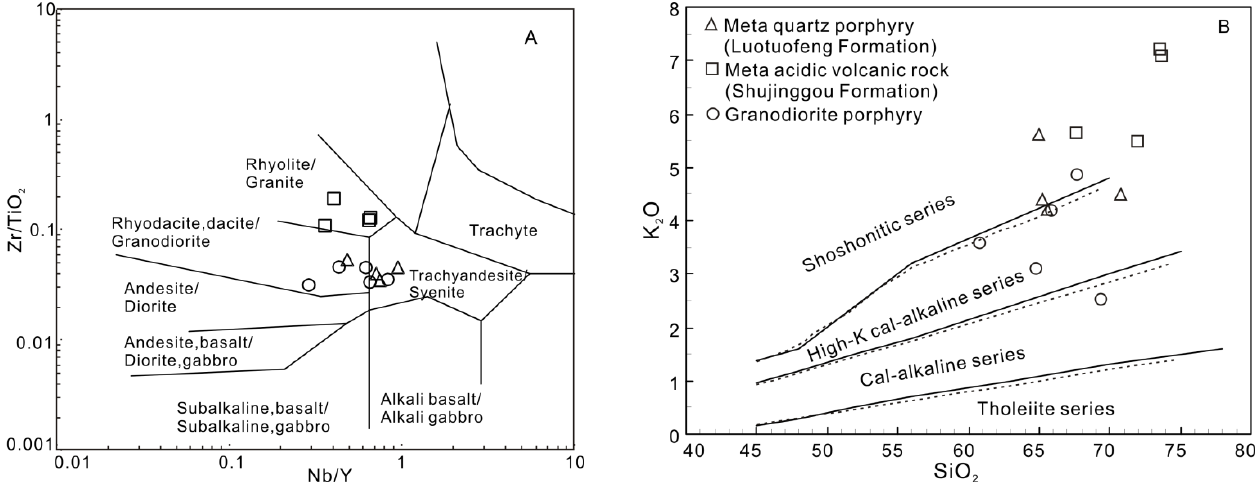
Figure 9. Nb/Y vs. Zr/TiO 2 ( A ) and SiO 2 vs. K 2 O ( B ) diagrams for the major rock types from the Tongkuangyu district (after Winchester and Floyd,1977 [48]; Middlemost, 1985, 1994 [49,50]; Peccerillo et al., 1976 [51]; andregional rock data from Yang et al., 2015 [52]). Table 3. Whole rock major and trace element compositions of Tongkuangyu granodiorite porphyry. Sample NO.